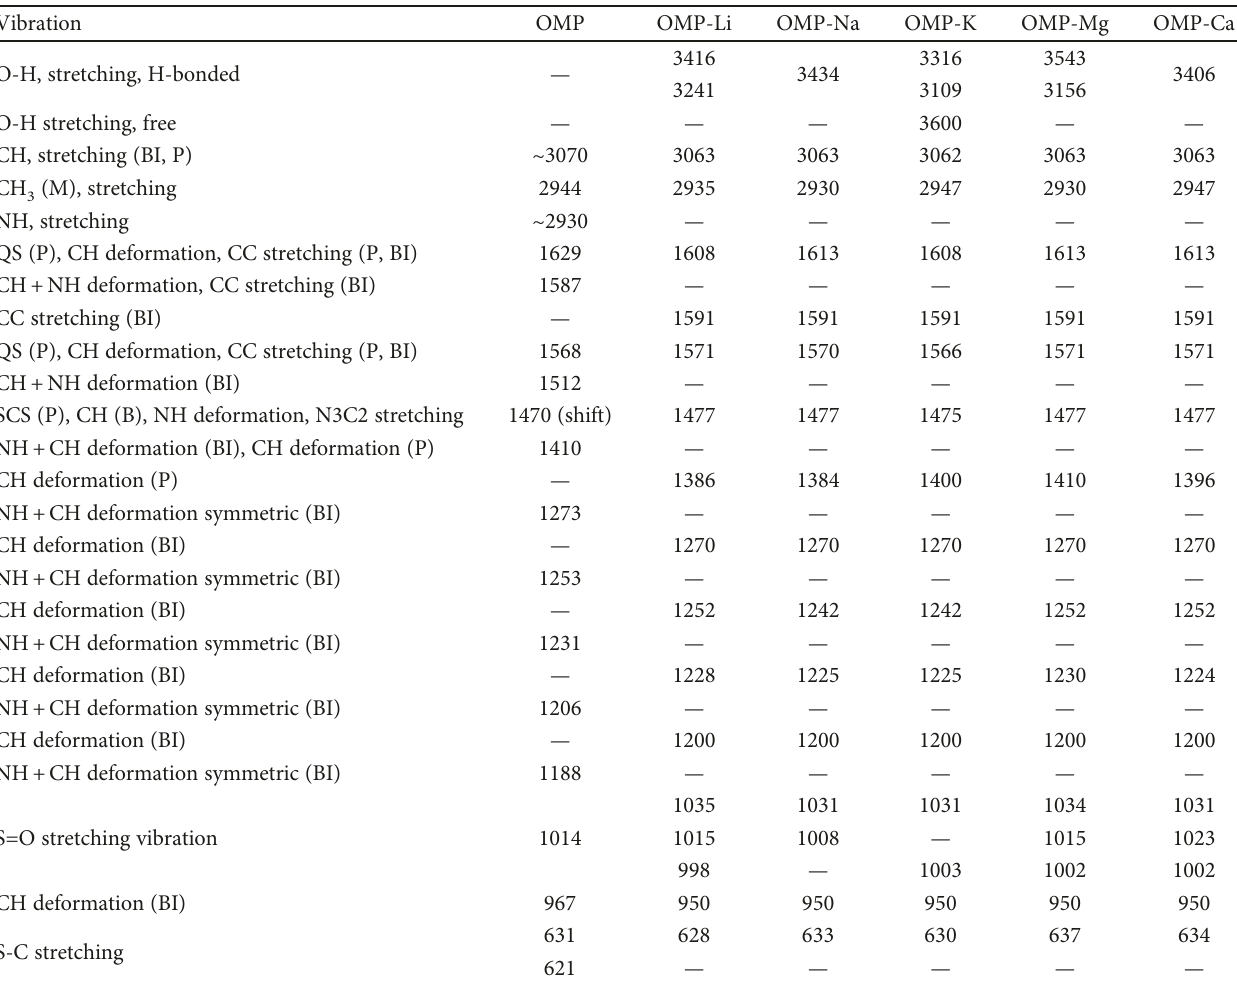
Figure 9: Raman (a) and infrared (b) spectra of OMP and prepared salts in solid state. (A) OMP, (B) OMP-Na, (C) OMP-Mg, (D) OMP-Li, (E) OMP-K, and (F) Table 4: Assignment of characteristic vibrations in infrared spectra of OMP and its salts.